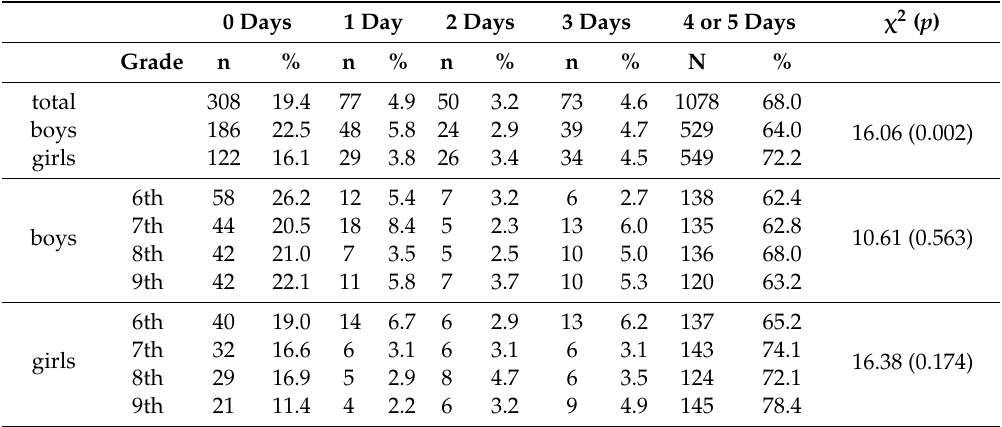
Table 1. Actual active commuting to school among Czech adolescents according to gender and class grade.